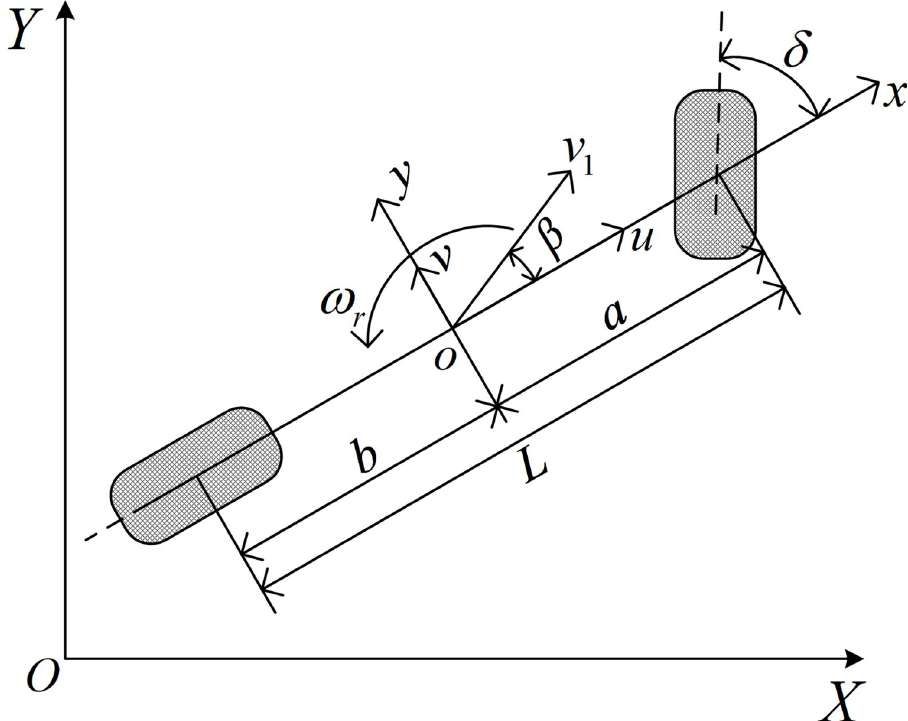
Fig 3. Three DOF model of a